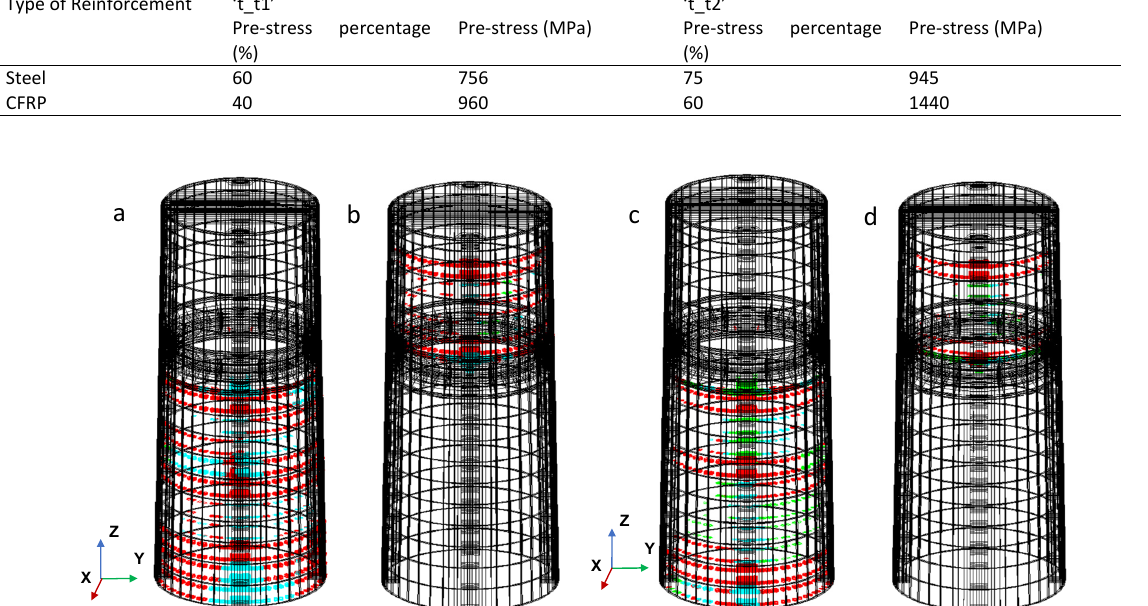
Figure 11. Crack pattern: (a) Lower ring and (b) Upper ring of ‘t_t1’; (c) Lower ring and (d) Upper ring of ‘t_t2’ (crack status: opening in red colour; closing in green colour, reopening in cyan colour).